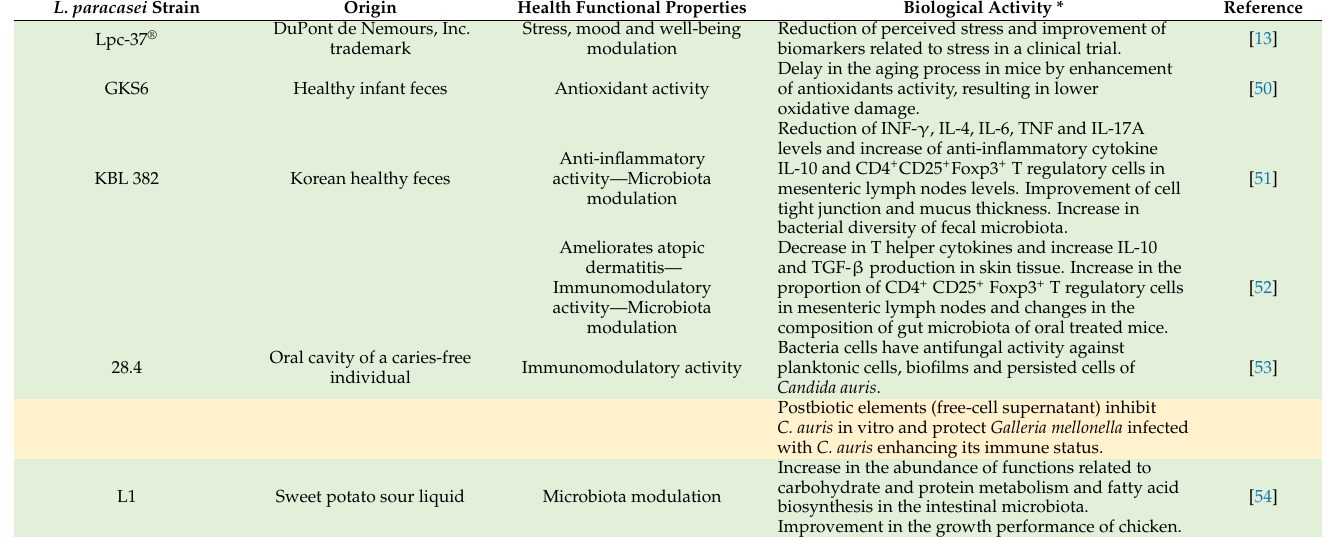
Table 1. Health functional properties attributed to Lacticaseibacillus paracasei strains isolated from different sources. L. paracasei